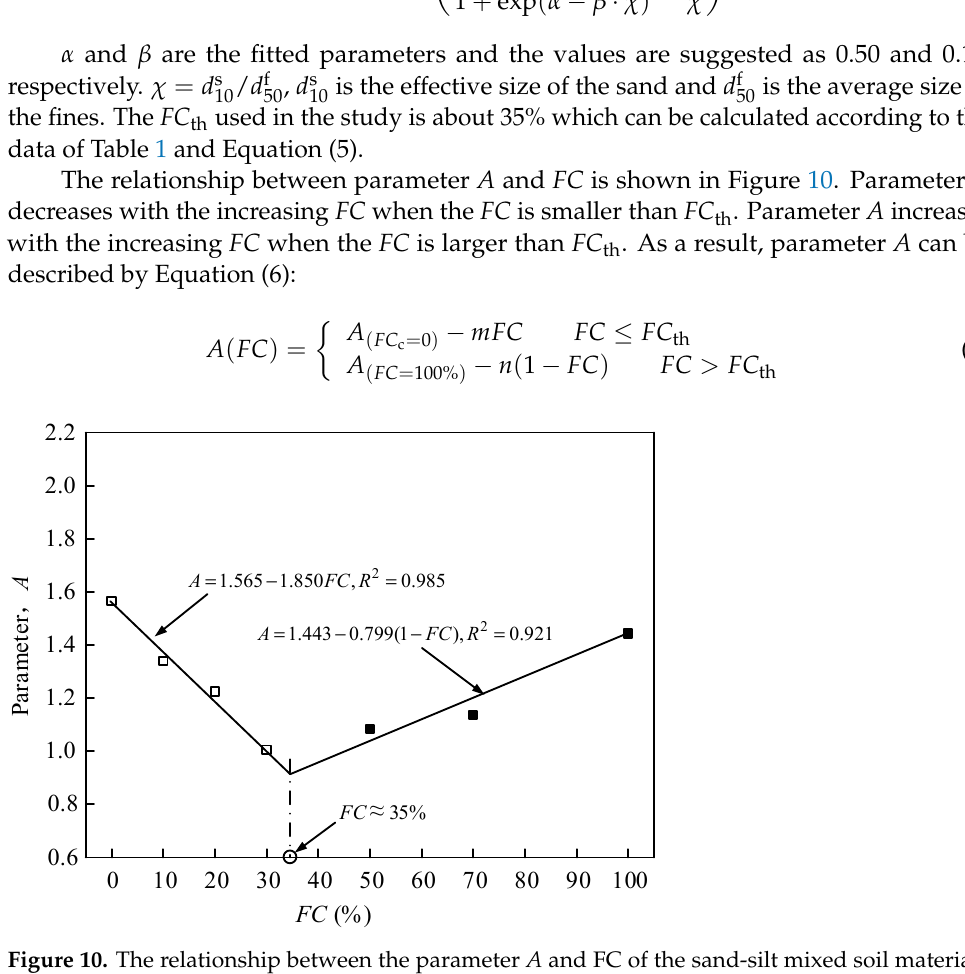
Figure 10. The relationship between the parameter A and FC of the sand-silt mixed soil materials. The □ represents a data point.